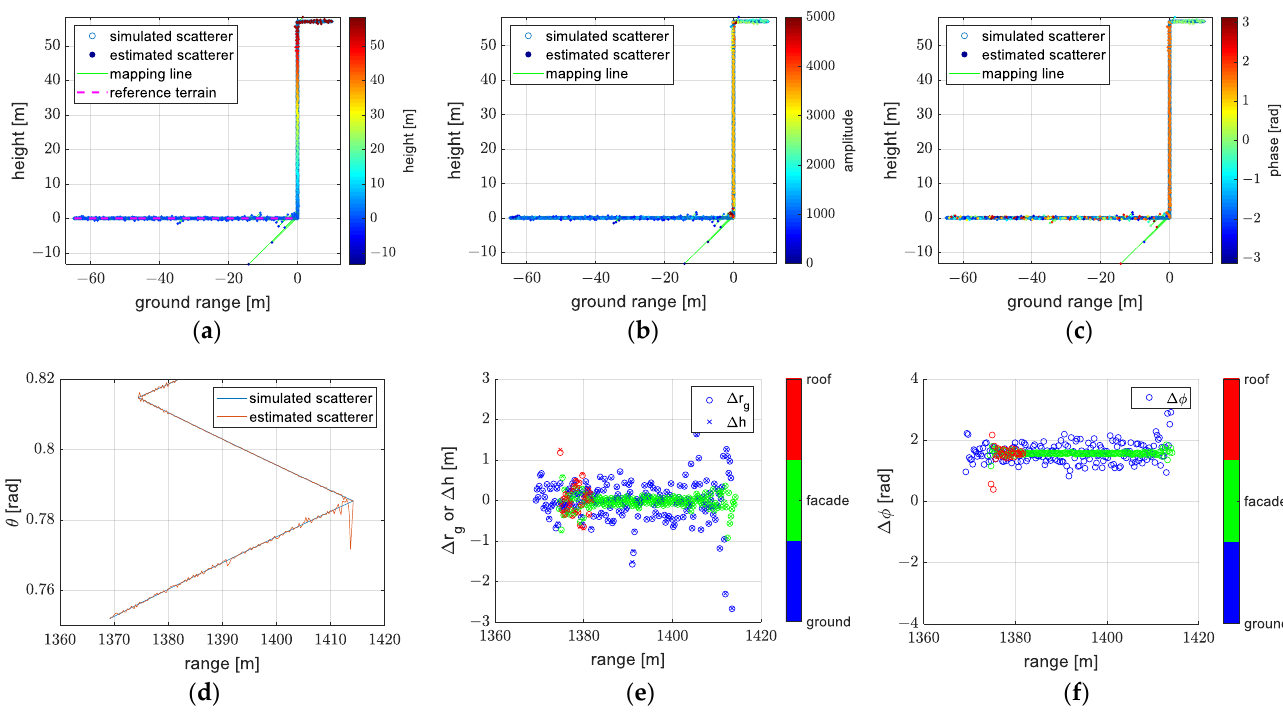
Figure 18. The reconstruction obtained under model 1 (the exact form of the planar wavefront model) in experiment 2: ( a ) reconstruction with colors denoted as height, ( b ) reconstruction with colors denoted as amplitude, ( c ) reconstruction with colors denoted as phase, ( d ) the off-nadir angle of the reconstruction, ( e ) the error of the ground range and height, ( f ) the error of the phase.